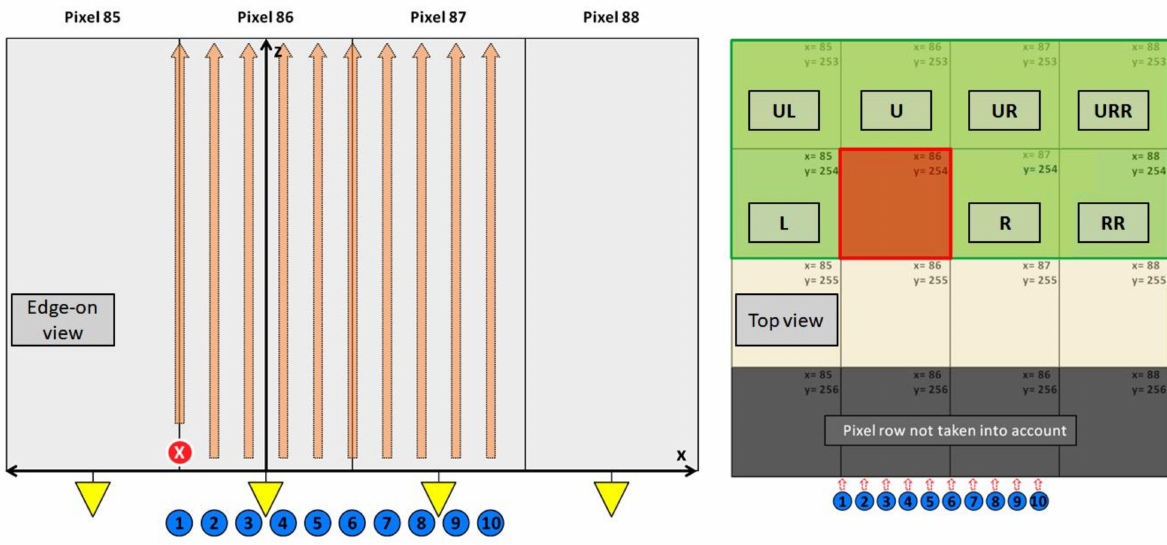
Figure 13. ( left ) Diagram of the edge-on measurement. The pixel rows 86 and 87 have been raster scanned with a focused 40 keV photon beam with a granularity of ∆ x = 15 µ m (10 scan points) and a ∆ z = 10 µ m (60 scan points). ( right ) The plot shows the top view on 4 × 4 pixels (x = 85–88 and y = 253–256). By using a photon finder algorithm only photons that were absorbed in the pixel row 254 were taken into account to avoid sensor corner effect. The response maps of the adjacent pixels were created, indicating the response of a pixel depending on the interaction point in the pixel under investigation (86, 254). As example, the plot indicates the assignment, when the photon absorption happens in pixel (86, 254) (red square). The letters indicate the following pixels (w.r.t. the pixel under investigation): L—left pixel, R—right pixel, RR—2 × right pixel, UL—upper left pixel, U—upper pixel, UR—upper right pixel, URR—upper 2 × right pixel. During the experiment two pixels have been scanned, namely (86, 254) and (87,